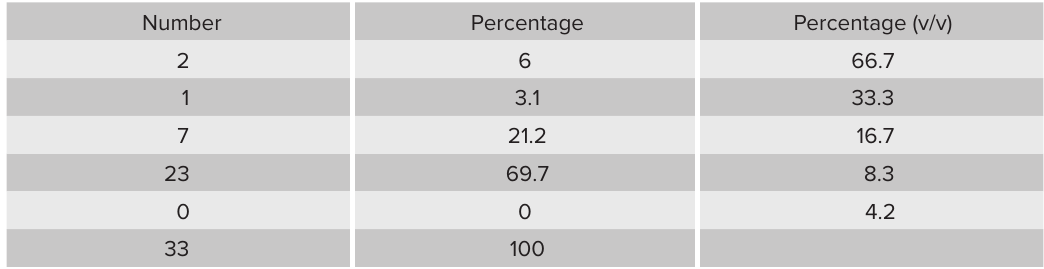
Table 4: Frequency of MIC of 33 Species of Honey-Sensitive Staphylococcus aureus